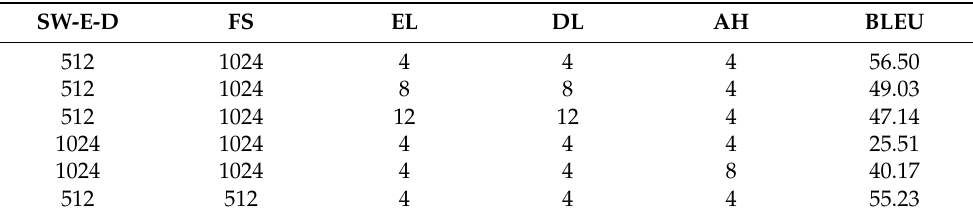
Table 5. Results of the Transformer-Based NMT Subword Model on MADAR–Iraqi corpus for IRQ– MSA translation task, where SW-E-D is the Subword embedding dimension, FS is the filter size, EL is the encoder layer, DL is the decoder layer and AH is the attention heads